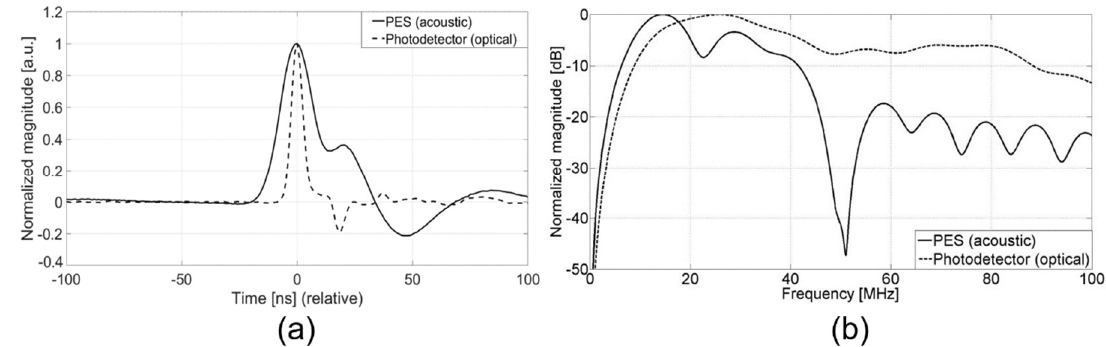
Figure 4. ( a ) Acoustic and optical waveforms measured by PES and high-speed photodetector. Both waveforms were normalized for pulse-width comparison. ( b ) Frequency spectra for the time-domain waveforms shown in ( a ).